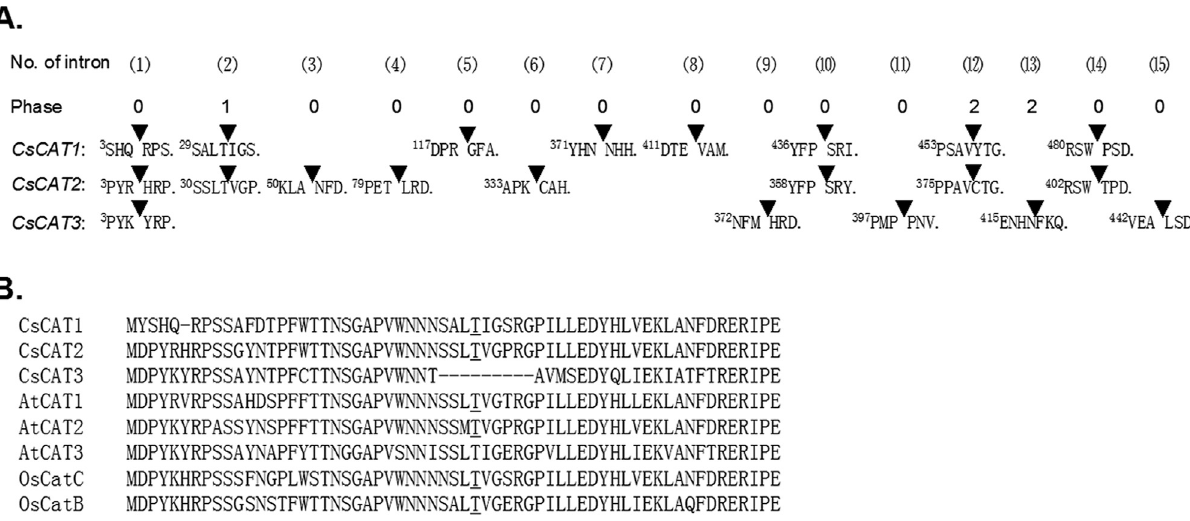
Figure 2 - Sequence analysis of plant catalase genes. (A) Nucleotide sequences surrounding splice sites in three cucumber CsCAT genes and the consen- sus sequence for the proto-splice site. Amino acid residues and codons ( solid triangles ) that are split by introns are also shown. (B) Amino acid sequences